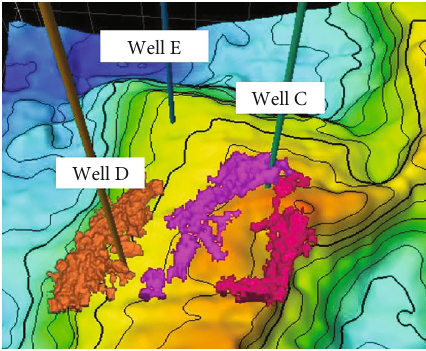
Figure 9: The igneous geobody beside Well C and Well D.